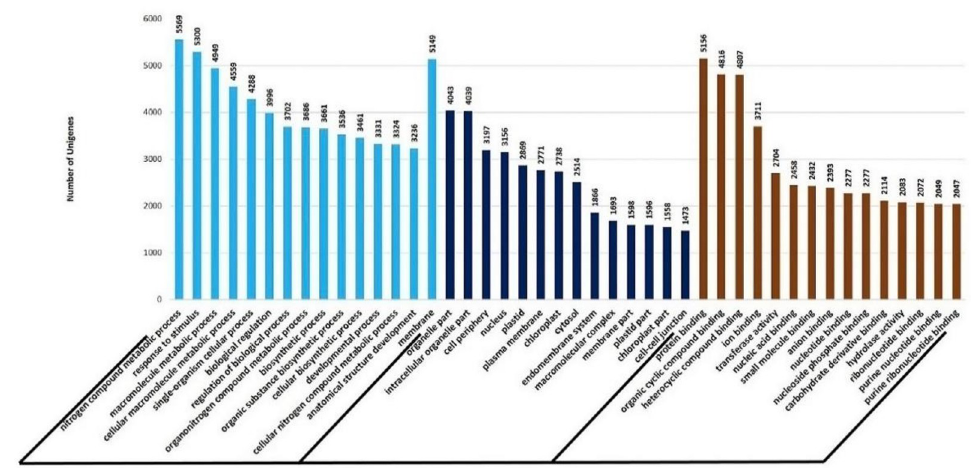
Fig 4. Gene ontology (GO) classification of L . tridentata